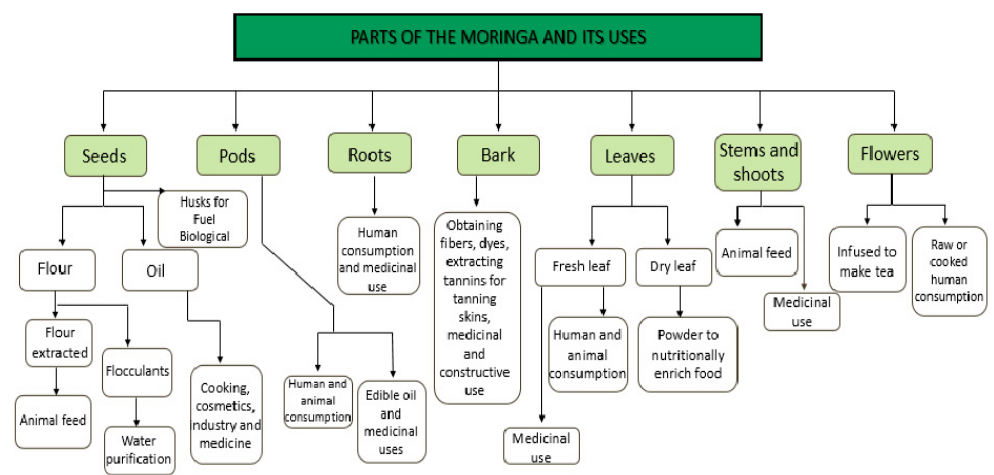
Figure 2. Diagram of the parts that mainly form the plant and its uses. (Adapted from [36].).